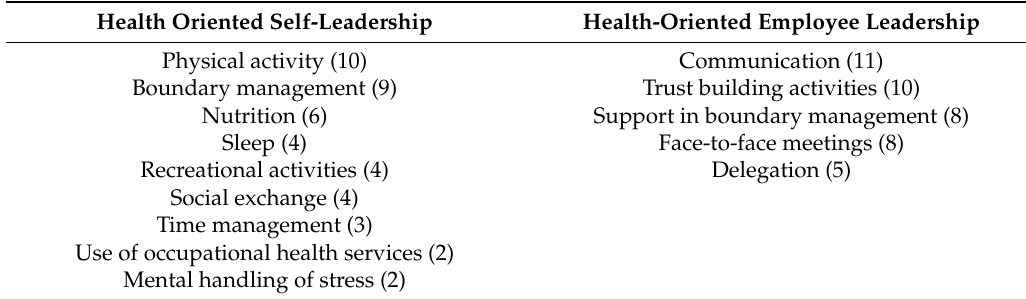
Table 3. Health-oriented leadership behaviors of virtual